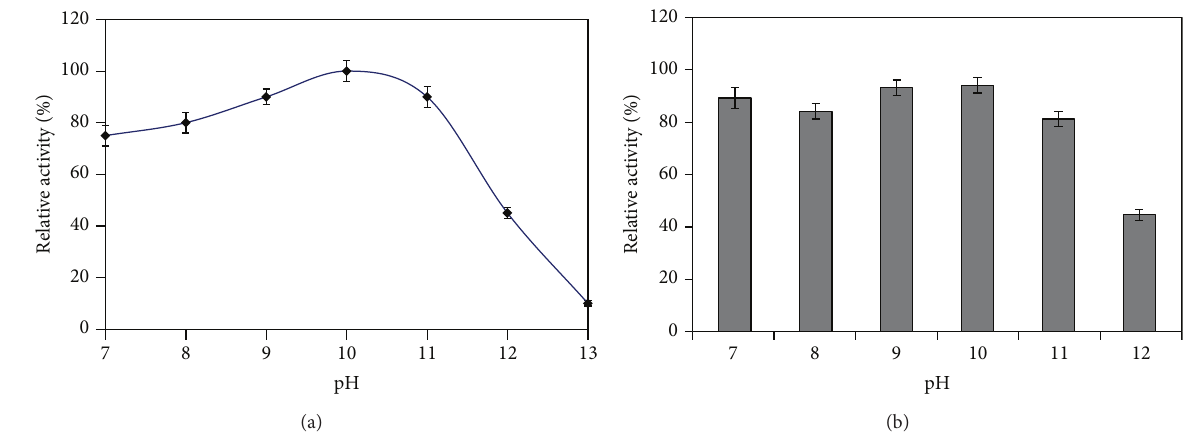
Figure 4: The effect of protease activity (a) and stability (b) by pH from strain SD11. (a) The enzyme activity was tested in different pH buffer solutions at 40 ∘ C. The enzyme activity was maximum at pH 10.0 regarded as 100%. (b) The protease stability against pH was examined after the enzyme was incubated in advance in different pH buffer solutions for 1 h at 40 ∘ C. The residual enzyme activity was tested at 40 ∘ C and pH 10.0. The enzyme activity without incubating was regarded as 100%. Each point indicates the average value of three times, and error bars show standard deviation.